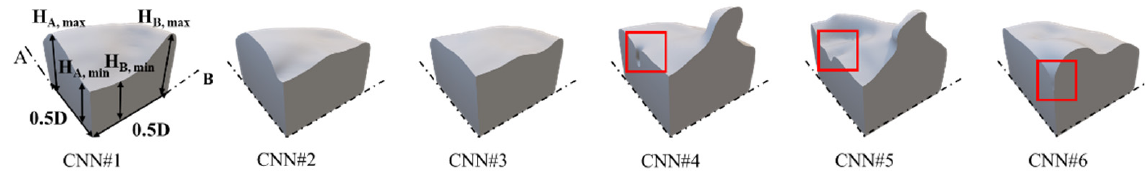
Figure 18. Preform shapes for the piston head forging with excluded preform geometries. Table 5. Height features of the derived preform shapes for the grinding tool-like shape.